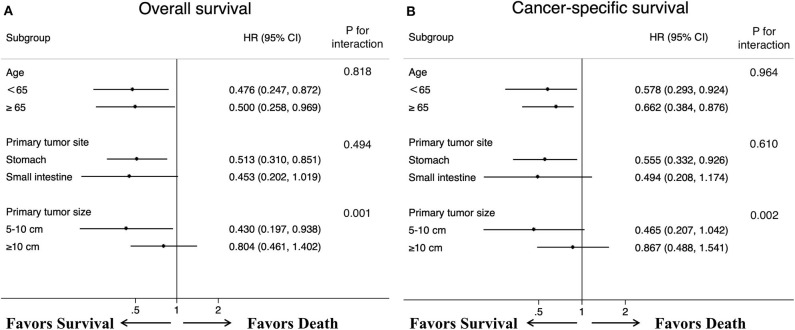
Forest plots summarize the HR and 95% CI of (A) overall and (B) cancer-specific survival according to whether patients underwent primary tumor surgery in subgroup analyses.